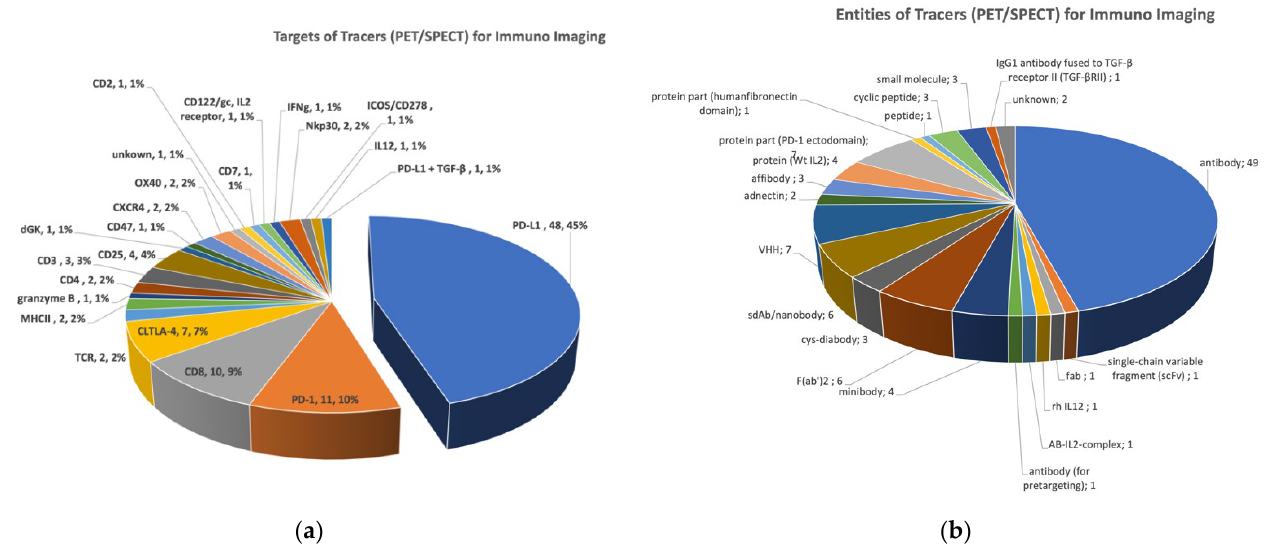
Figure 1. Data analyses of published immuno-imaging reagents (PET/SPECT) ( a ) Representation of targets addressed with selective PET or SPECT tracers. ( b ) Proportional representation the biological and chemical entities.